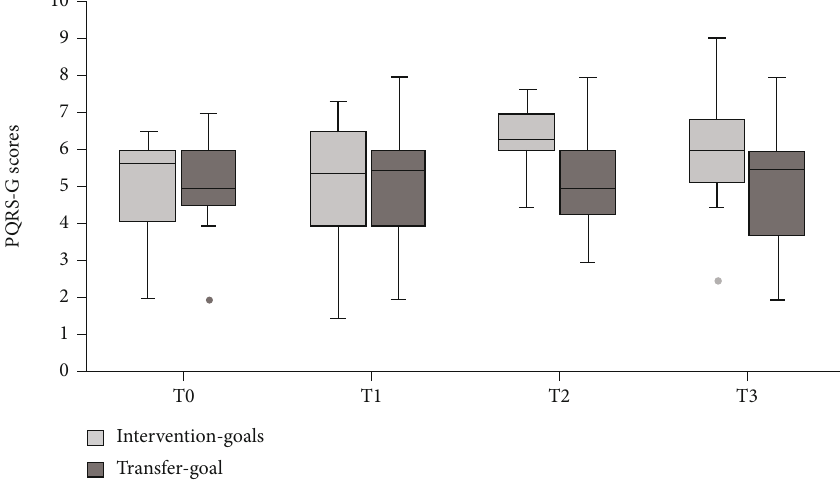
Figure 4: Changes in Performance Quality Rating Scale Generic (PQRS-G) scores over time for the intervention goals and transfer goal separately. The boxplots show the median, the fi rst and third quartile, the range, and the outliers. Table 4: Post hoc analyses for the PQRS-G scores of the intervention goals. Intervention